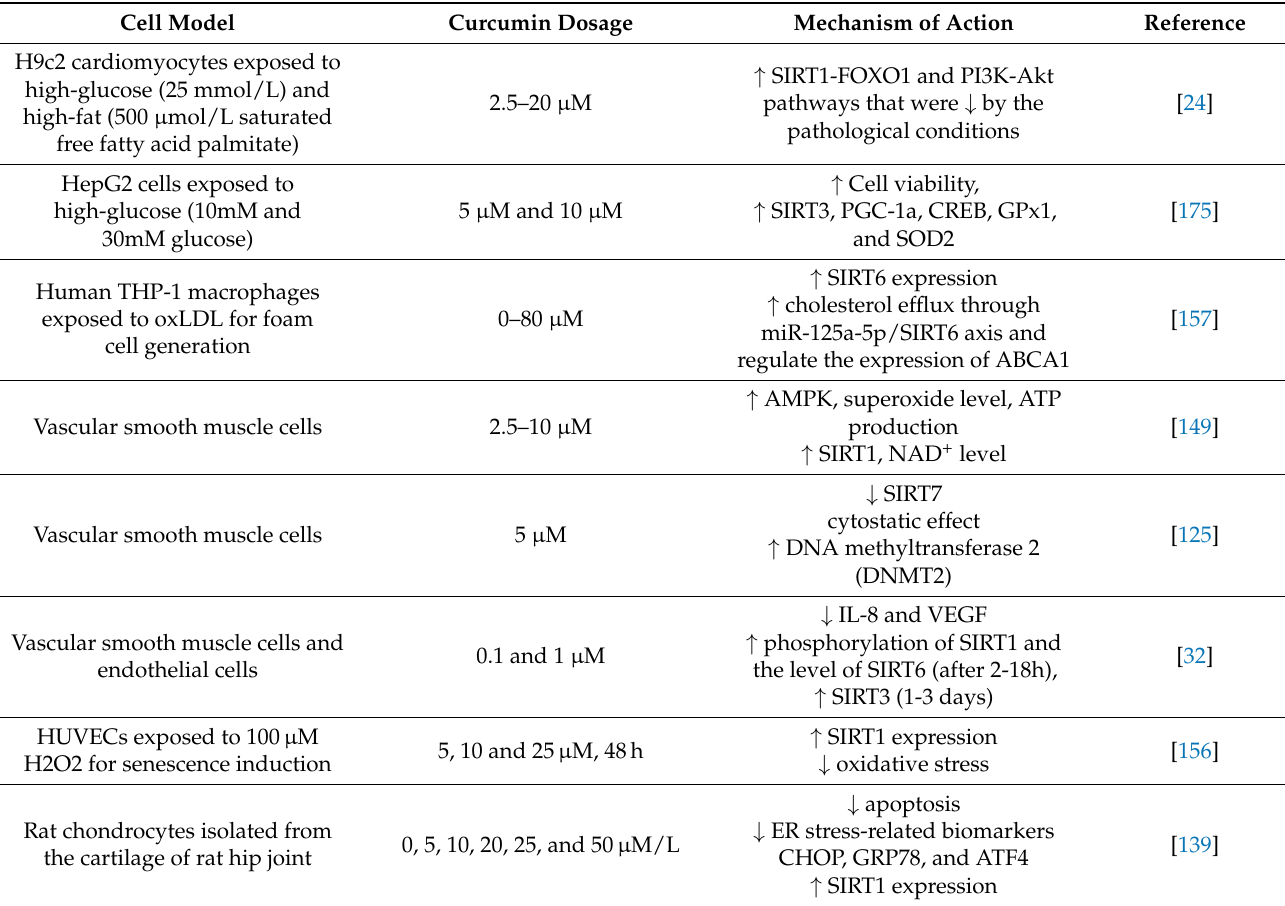
Table 2. Experimental results regarding the effects induced by curcumin in cell models, through modulation of sirtuin activity and